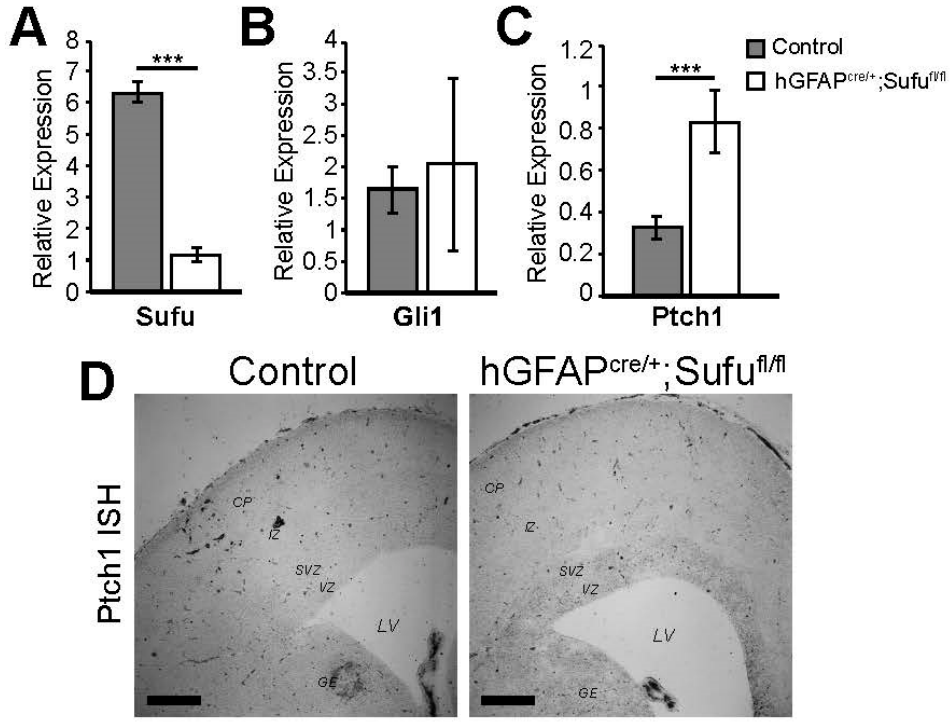
Figure 6. Ectopic expression of Ptch1 in the E16.5 hGFAP cre/+ ;Sufu fl/fl VZ/SVZ. ( A – C ) quantitative PCR (qPCR) analysis of mRNA extracted from the neocortex showed downregulation of Sufu as expected in the E16.5 hGFAP cre/+ ;Sufu fl/fl neocortex ( A ); No changes in Gli1 expression were detected between control and mutant neocortex as previously reported ( B ); However, a significant increase in the expression of Ptch1 was detected in the E16.5 hGFAP cre/+ ;Sufu fl/fl neocortex compared to controls ( C ) indicating activation of Sonic Hedgehog (Shh) signaling; *** p -value < 0.01; ( D ) In situ hybridization using Patched-1 (Ptch1)-specific riboprobes showed ectopic expression of Ptch1 in the VZ/SVZ of the E16.5 hGFAP cre/+ ;Sufu fl/fl neocortex. Scale bars = 200 μ m.